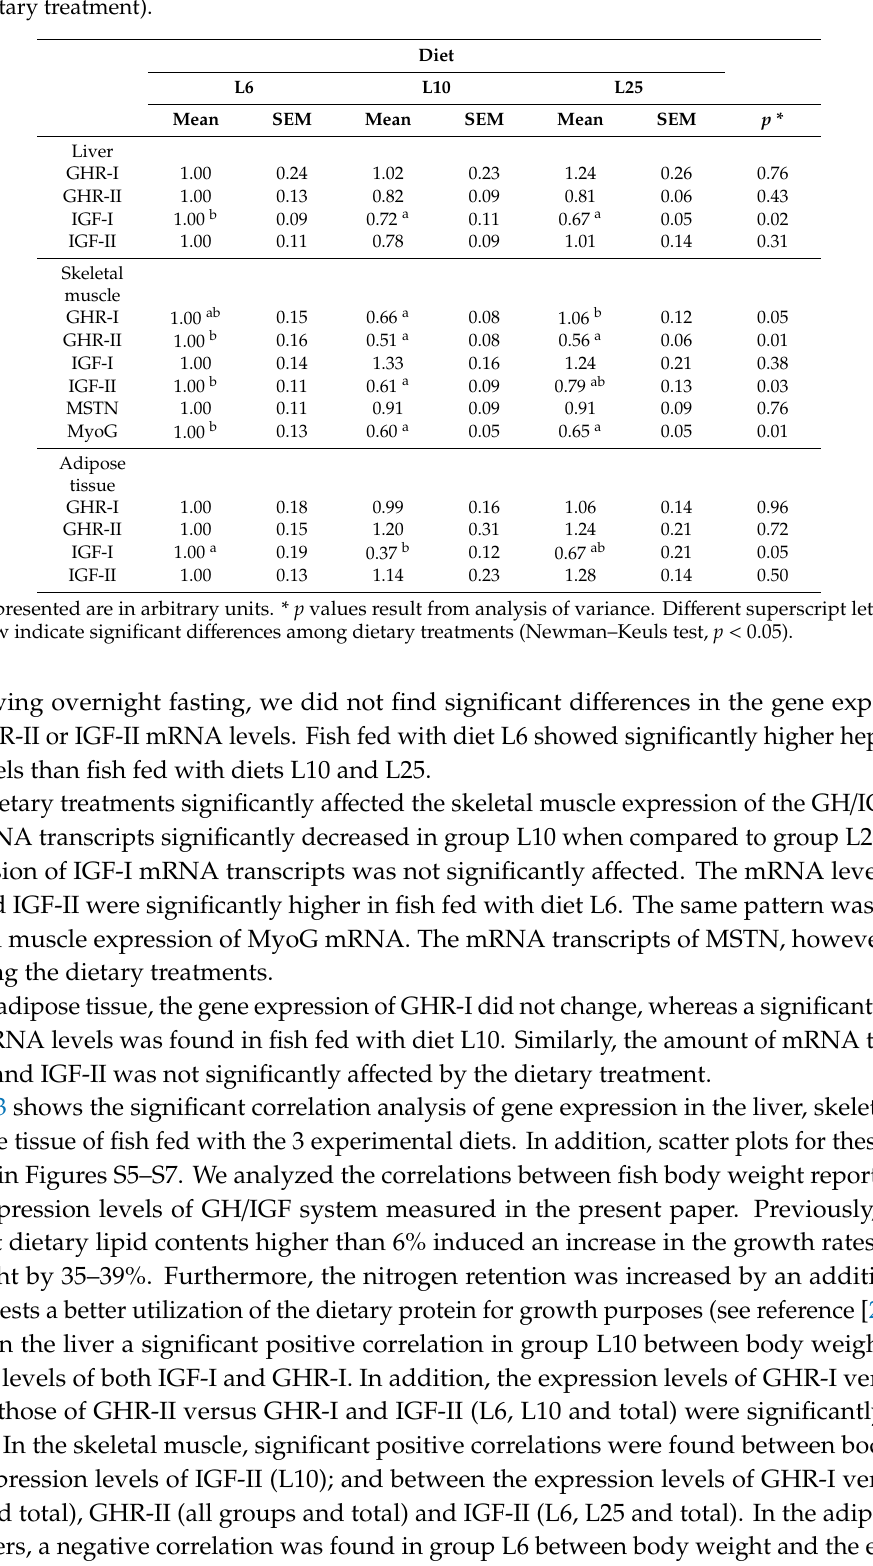
Table 2. Data on tissue expression (arbitrary units) of GHR-I, GHR-II, IGF-I, IGF-II, MSTN and MyoG in fish fed the experimental diets for 14 weeks. (Mean values and standard errors of the mean of 12 fish per dietary